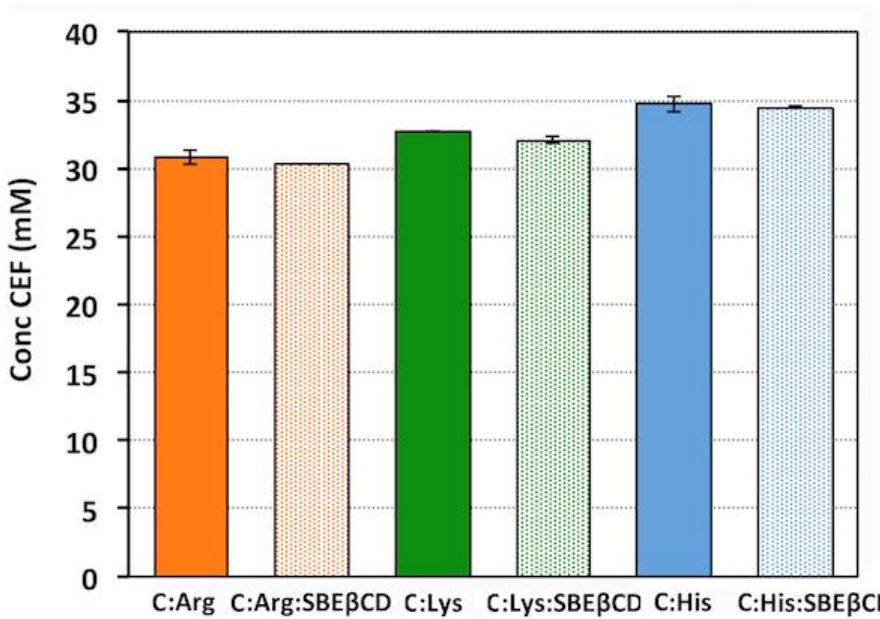
Figure 4. Solubility in water at 25 ◦ C of CEF in binary (full bars) and ternary (dotted bars) mixtures with basic AA (Arg, Lys and His) and SBE β CD in the 1:2 and 1:2:1 molar